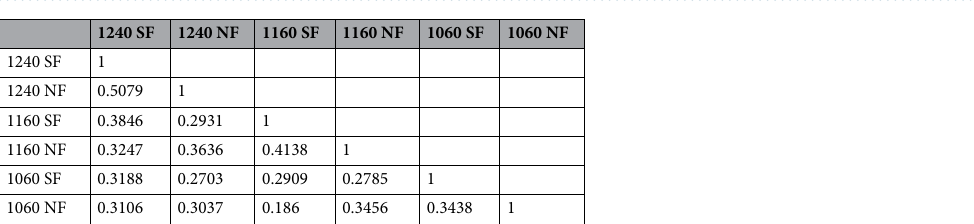
Table 3. JACCARD similarities between different elevation belts within site II. SF, south facing; NF, north